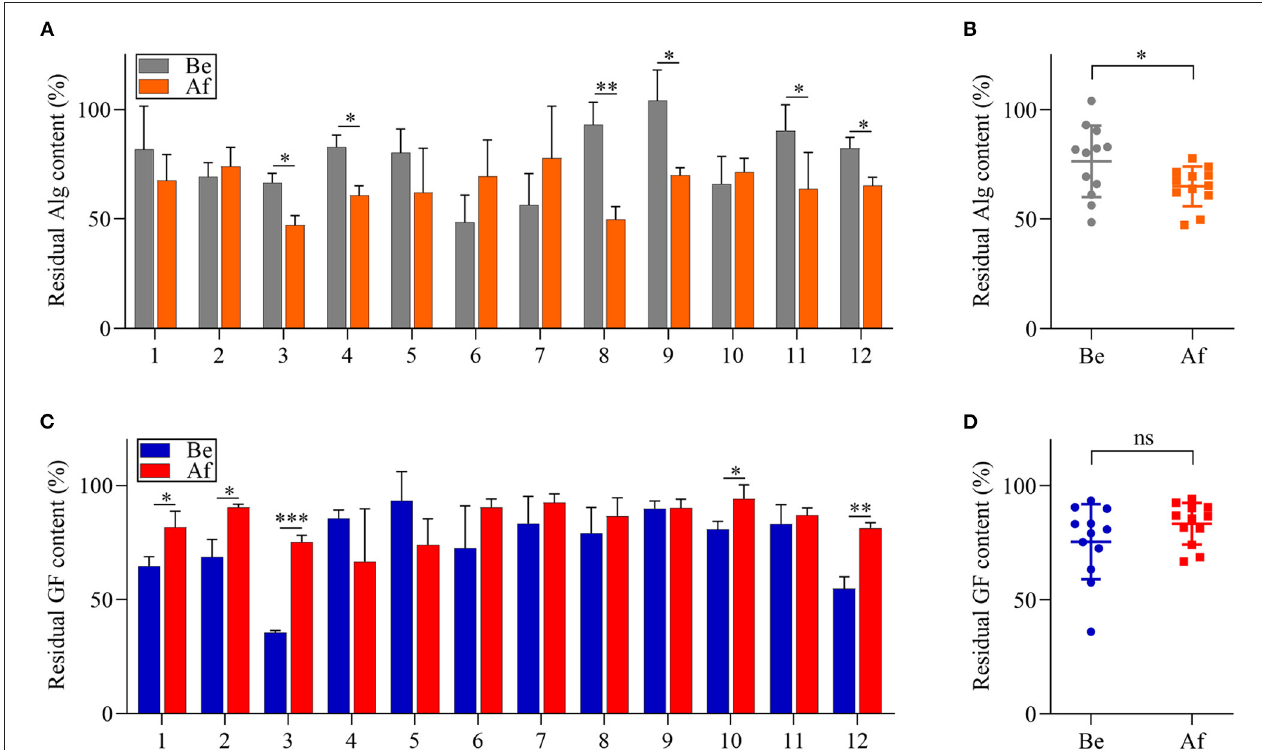
FIGURE 3 | The comparisons of alginate (Alg) and galactofucan (GF) utilization by fecal microbiota collected Be and Af L. japonica intake in individuals (A,C) and in groups (B,D) . * p < 0.05, ** p < 0.01, *** p < 0.001; ns, no significant difference.